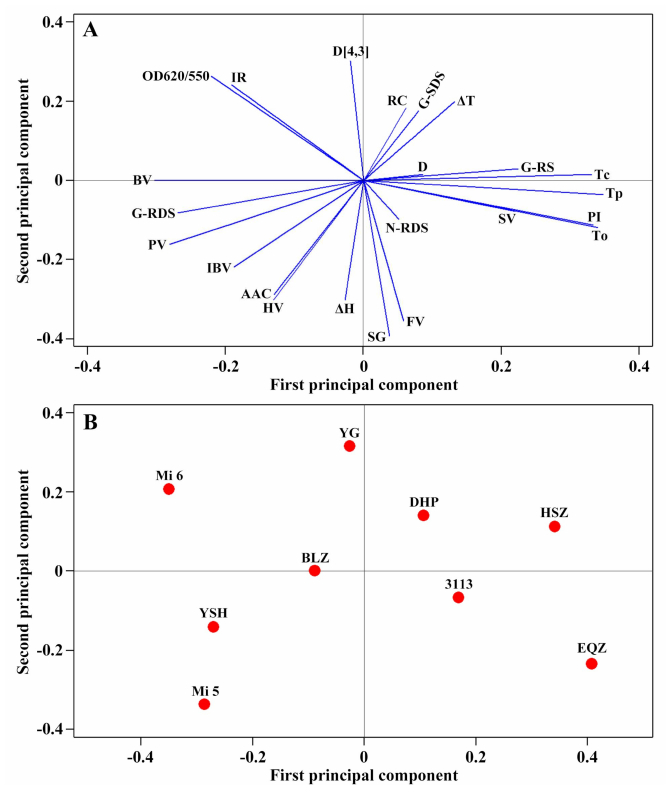
Figure 9. Loading ( A ) and score plots ( B ) of principal component analysis based on physicochemical properties of starches from nine Chinese chestnut varieties. The abbreviations in ( A ) are listed below: AAC, apparent amylose content; D, lamellar distance; D[4,3], volume-weighted mean diameter; IBV, iodine blue value of starch; IR, absorbance ratio of 1045/1022 cm − 1 in FTIR spectrum; N-RDS, rapidly digestible starch in native starch; G-RDS, SDS, and RS, rapidly digestible starch, slowly digestible starch, and resistant starch in gelatinized starch; OD620/550, absorbance ratio of OD620 to OD550 in iodine absorbance spectrum of starch; PI, lamellar peak intensity; PV, HV, BV, FV, and SV, pasting peak, hot, breakdown, final, and setback viscosity, respectively; RC, relative crystallinity; SG, volume percentage of small starch granule; To, Tp, and Tc, gelatinization onset, peak, and conclusion temperature, respectively; ∆ T, gelatinization temperature range; ∆ H, gelatinization enthalpy. The abbreviations of varieties in ( B ) are listed below: BLZ, Benlizi; DHP, Dahongpao; EQZ, Erqingzao; HSZ; Heishanzhai 7; YG, Yangguang; YSH,